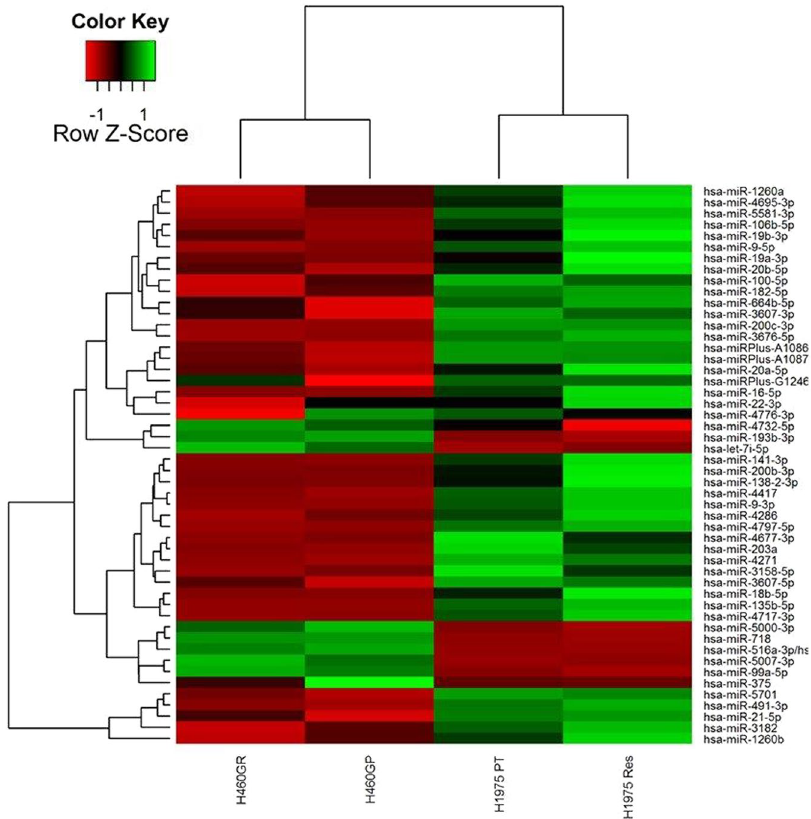
Figure 3. Heat map and hierarchical clustering of H460GP, H460GR, H1975GP and H1975GR miRNA screen. miRNA have previously been shown to regulate resistance to targeted therapies. Here, H460GP, H460GR, H1975GP and H1975GR miRNA samples were screened for miRNA expression by Exiqon services using the miRCURY LNA microRNA array. The top 50 miRNAs (in terms of differential expression) are hierarchically clustered